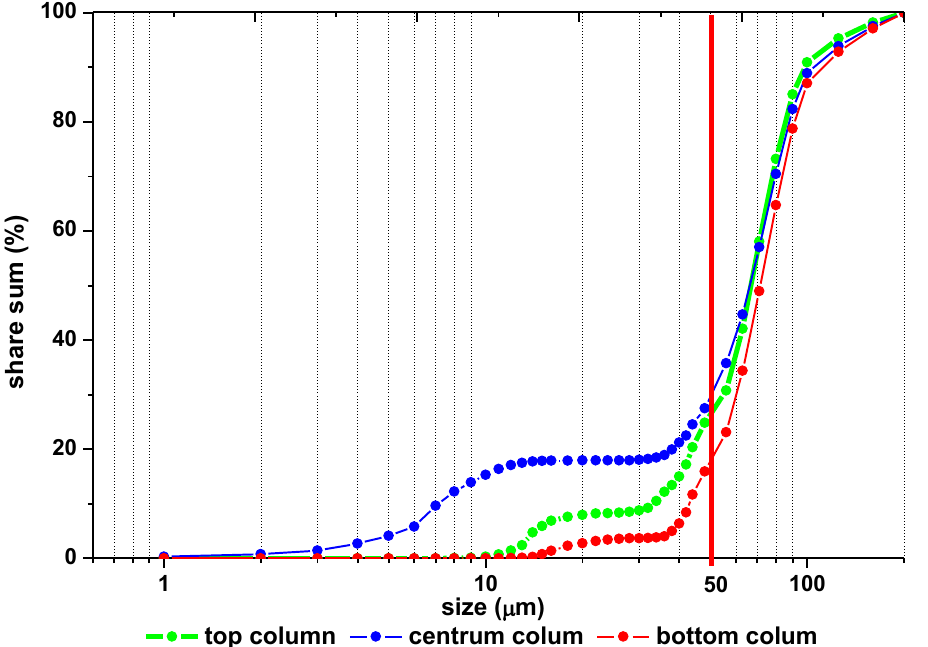
Figure 13. Distribution of grain classes at each level of column 6.